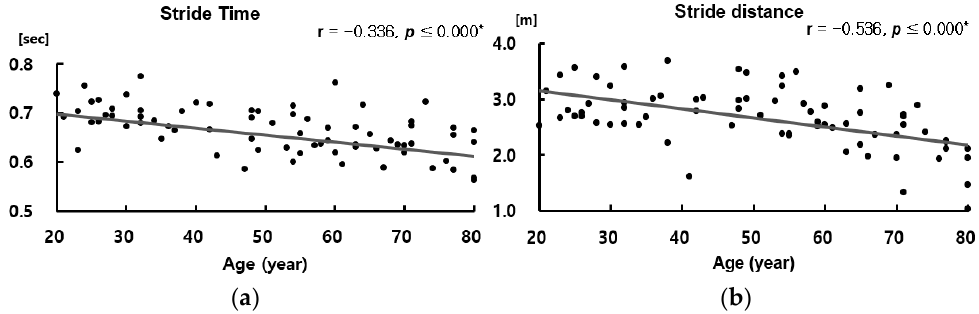
Figure A2. Correlations between age and impact and running characteristics. ( a ) Stride time, ( b ) stride distance. * p < 0.05 indicates significant correlations between age and the variables.